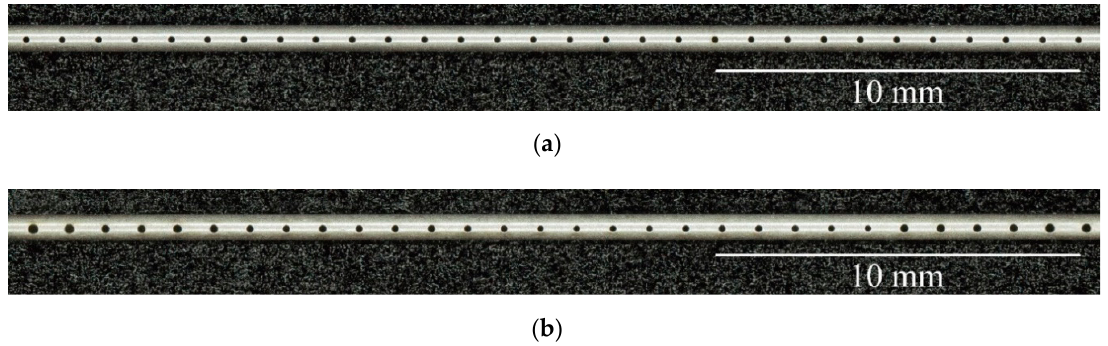
Figure 10. Tube electrodes with micro-holes: ( a ) Uniform diameter; ( b ) varying diameter.